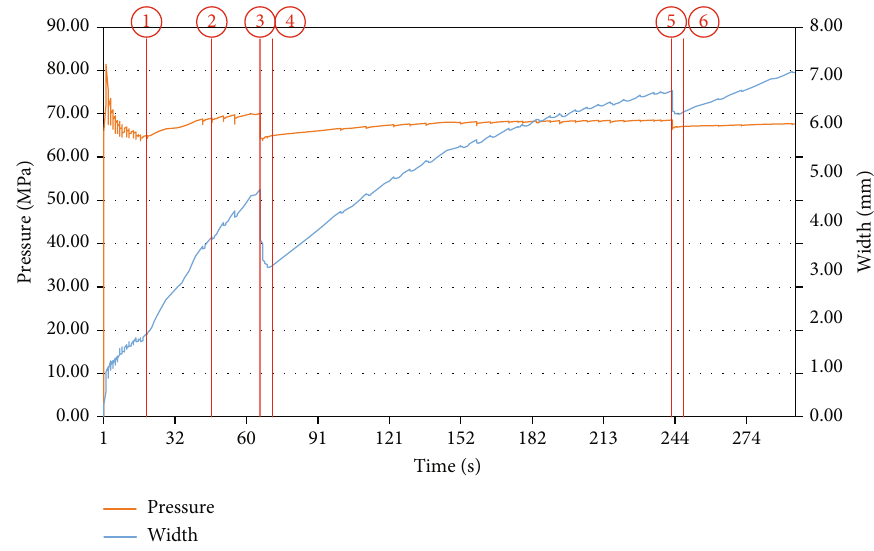
Figure 19: The responses of injection pressure and fracture width during height growth in the reservoir with asymmetric mud